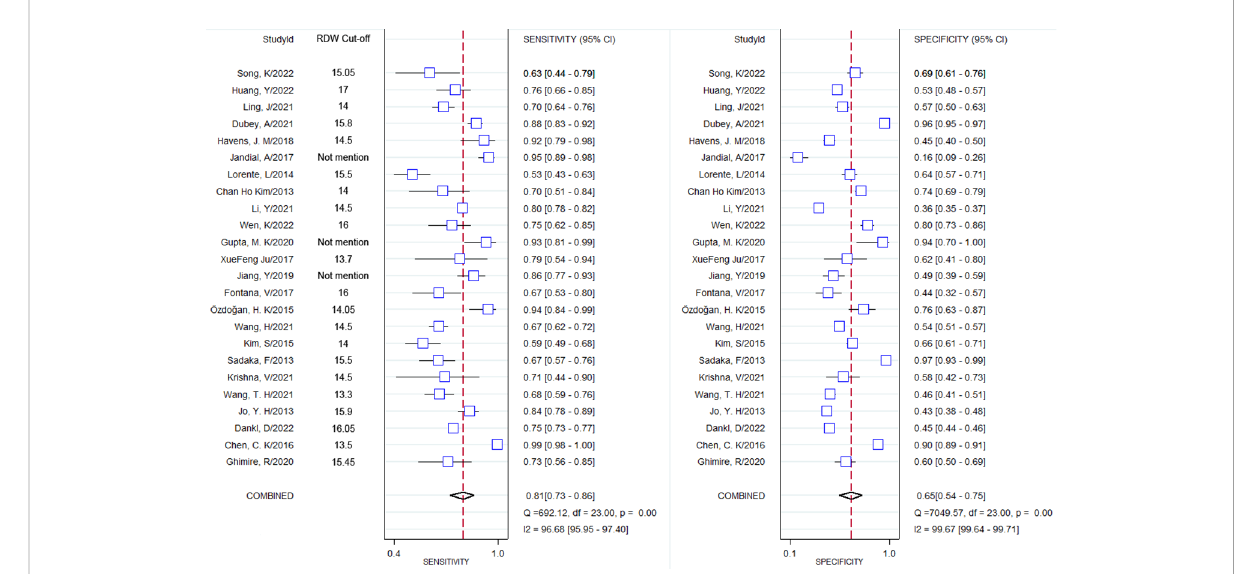
FIGURE 3 Forest plot of combined sensitivity and combined speci fi city and their corresponding 95% Cl.